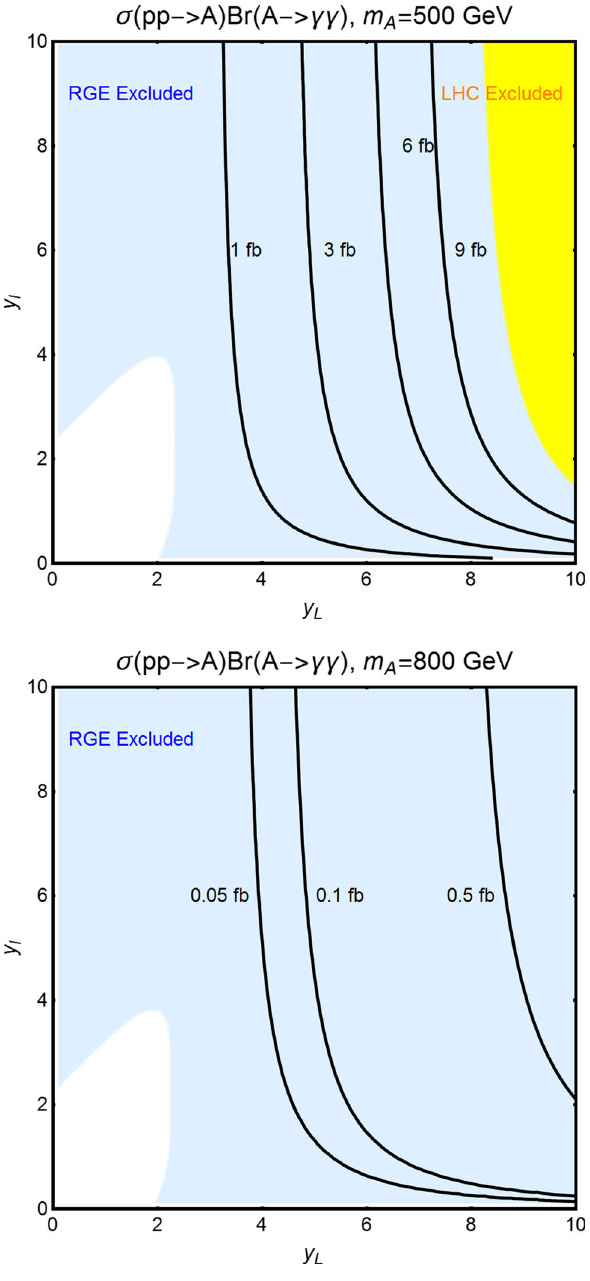
Fig. 6 Contours of the process pp → A → γγ for the two values m A = 500GeV ( upper panel ) and m A = 800GeV ( lower panel ), as function of the parameters y l , L (see main text). In both plots we have considered type-I 2HDM with tan β = 1. The yellow region in the left panel is excluded by present LHC searches. In the region at the left of the 1 fb ( upper panel ) and 0.05 fb ( lower panel ) contours, the production cross section varies in a negligible way with y l , L and basically coincides with the prediction of the 2HDM without VLLs. The blue region corresponds to theoretically inconsistent, because of RGE effects, values of the Yukawa parameters